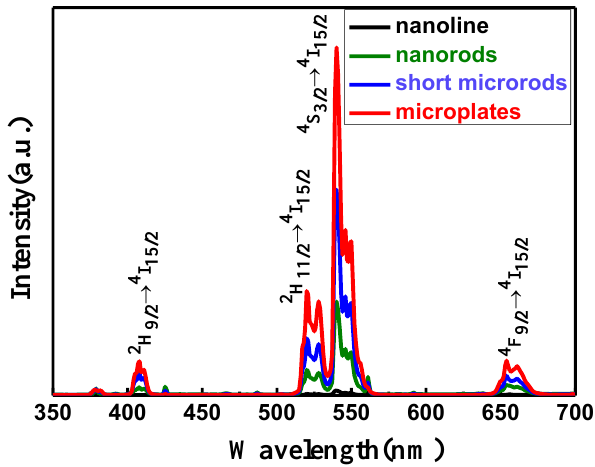
:10% Nd 3+ ,10% Yb 3+ , 2% Er 3+ 4